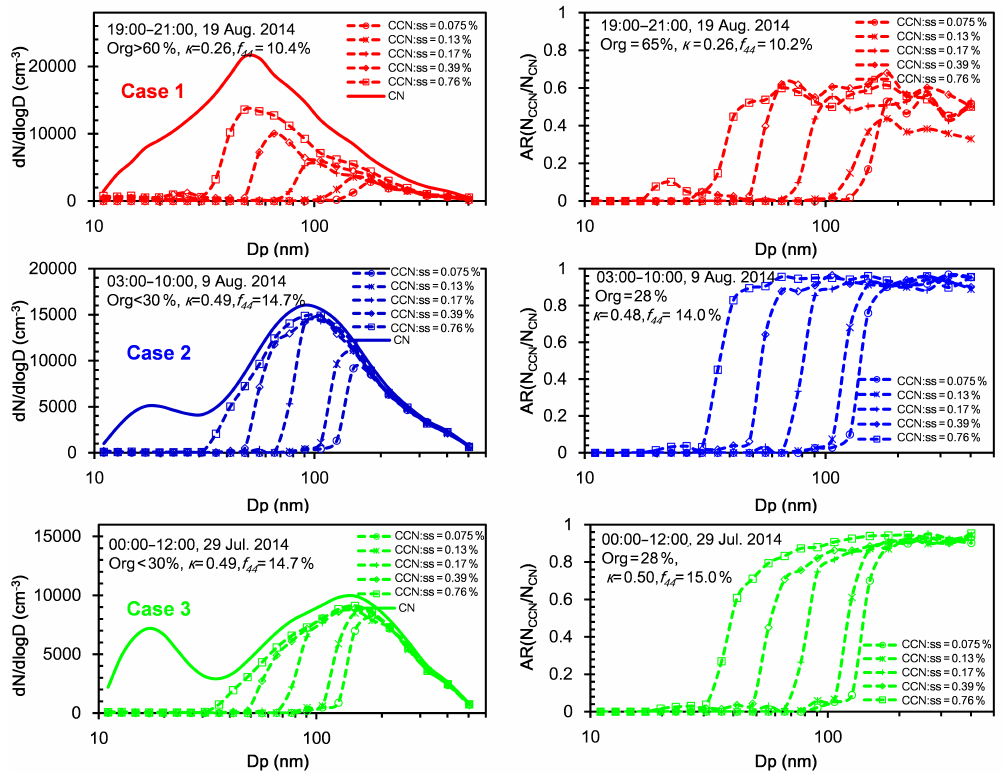
Figure 2. Particle number size distribution (PSD) and CCN size distributions (left panels) and CCN efficiency spectra (right panels) at different supersaturation levels for Case 1 (upper panels; 19 August 2014, 19:00–21:00LT), Case 2 (middle panels; 9 August 2014, 03:00– 10:00LT), and Case 3 (bottom panels; 29 July 2014, 00:00–12:00LT). Total CN number concentrations are 16671, 12869, and 10134cm − 3 for Case 1, Case 2, and Case 3, respectively. Mass concentrations of PM 1 are 28.36, 81.45, and 78.73µgm − 3 for Case 1, Case 2, and Case 3, respectively.